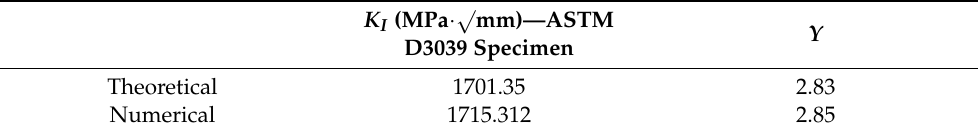
Table 9. The stress intensity factor (K 1 ) and the geometry correction factor ( Y ) for TTC specimens as ( a/W = 0.5).